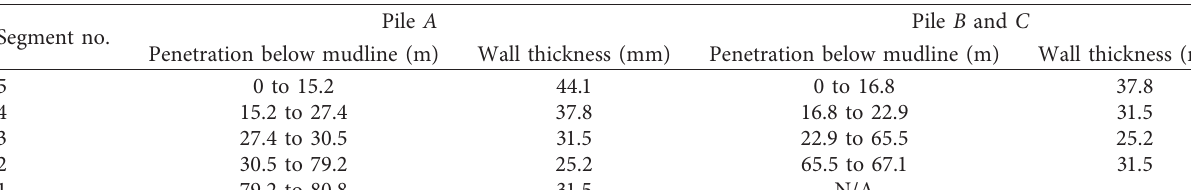
Table 1: Pile diameter and wall thickness